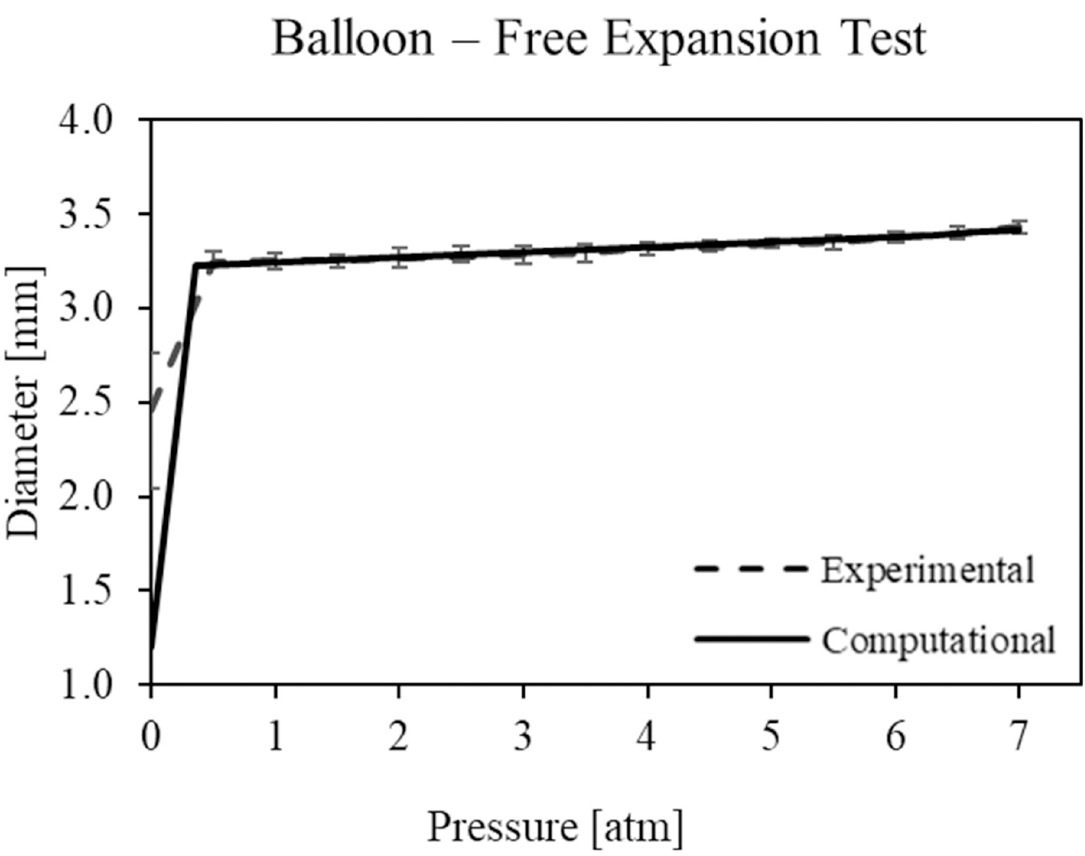
Fig 6. Comparison between the experimental and computational pressure-diameter curves from free-expansion of the balloons. Error bars indicate the maximum and minimum experimental value of diameter reached with respect to the mean value at the corresponding pressure.